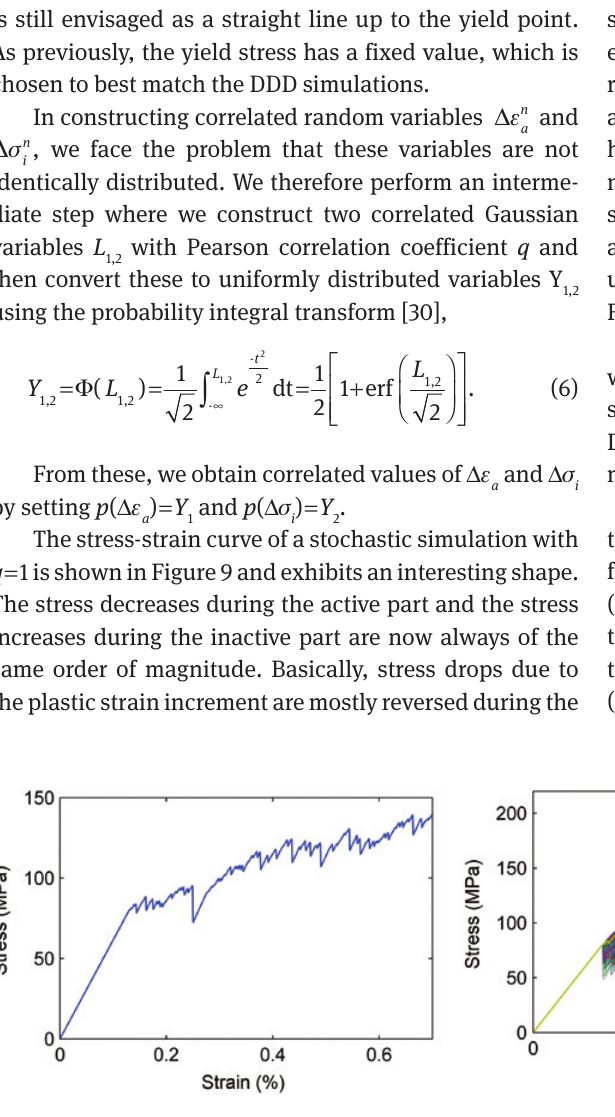
Figure 9: Left, stress-strain curve calculated from the correlated stochastic model for correlation factor equal to 1. Right, 1000 stress-strain curves from correlated stochastic simulations with correlation factor q = 1, the elastic part coincides for all the simulations.